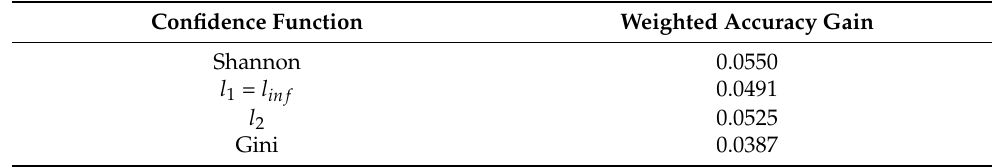
Table 4. Comparison of weighted accuracy gain with different confidence